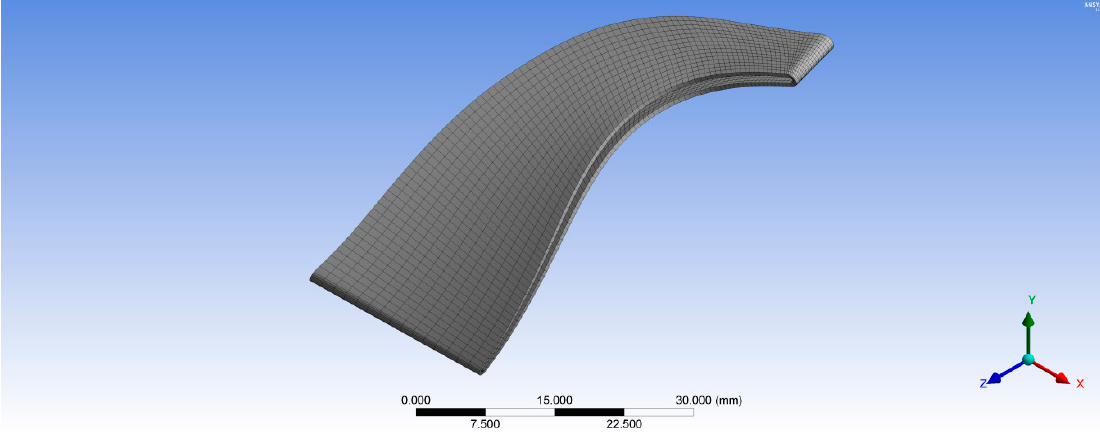
Figure 7. Three-dimensional structural mesh for one rotor blade.